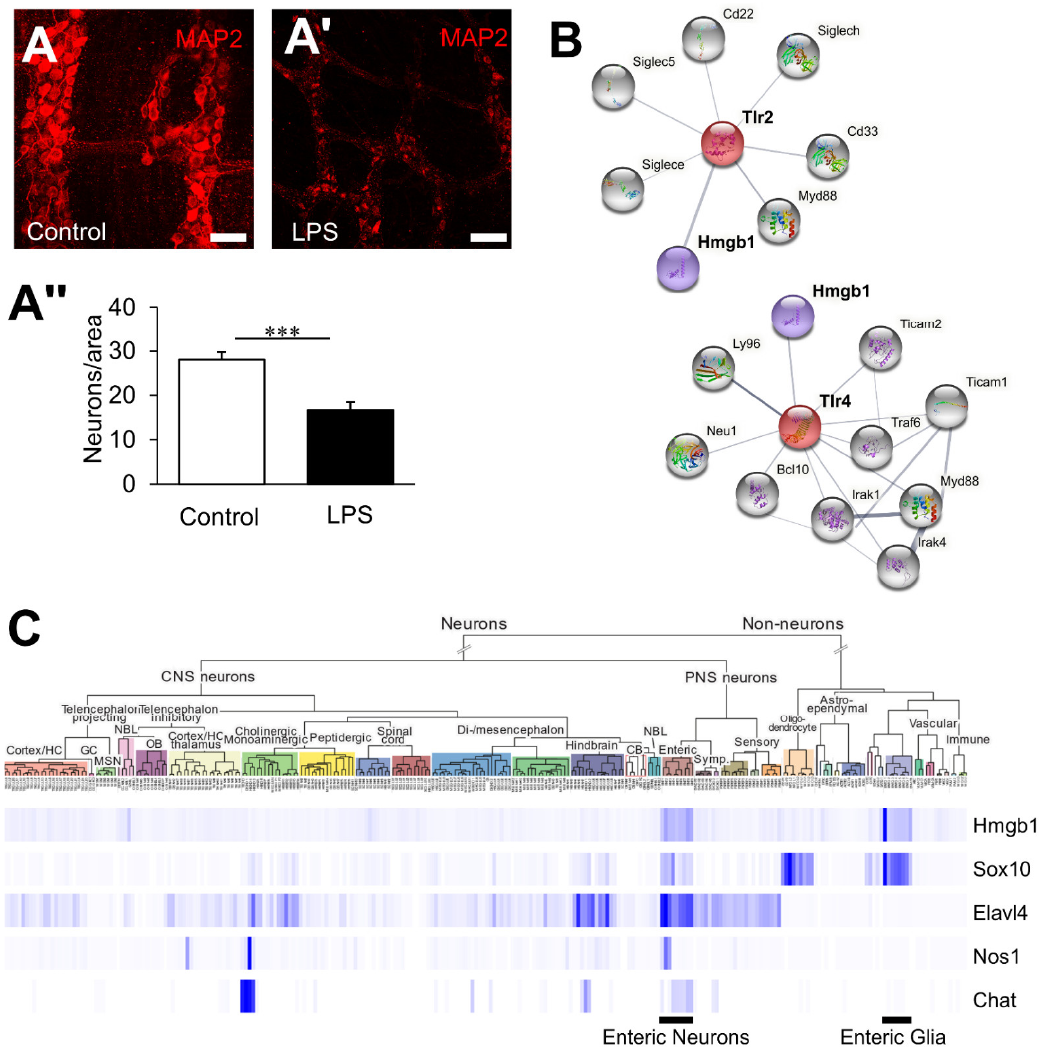
Figure 1. HMGB1 is a candidate endogenous TLR signalling cytokine in enteric neuroinflammation. ( A , A’ ) Neurons within the myenteric ganglia were observed by immunofluorescence using the neu- ronal marker MAP-2 in distal colon organotypic cultures. Tissues were cultured for 24 h in standard culture medium ( A ) or in the presence of LPS (scale bar = 50 µm). ( A’’ ) Quantification of myenteric neuron density expressed as the number of neurons per ganglionated area. *** p < 0.001; control: n